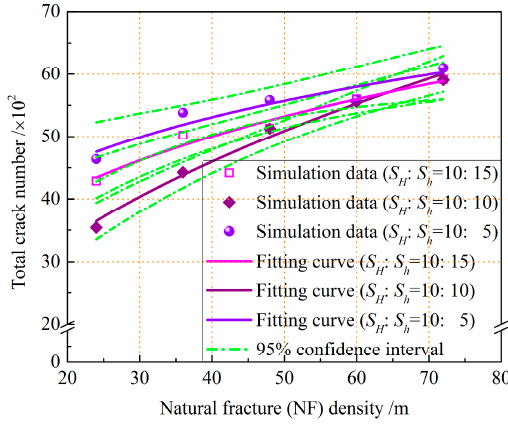
Figure 23. Incremental accumulation of TCRM, SCRM, TCNF, and SCNF in various NF densities when injection rate is 2.0 × 10 − 6 m 3 /s; ( a ) ρ = 24/m; ( b ) ρ = 36/m; ( c ) ρ = 48/m; ( d ) ρ = 60/m; and ( e ) ρ = 72/m.